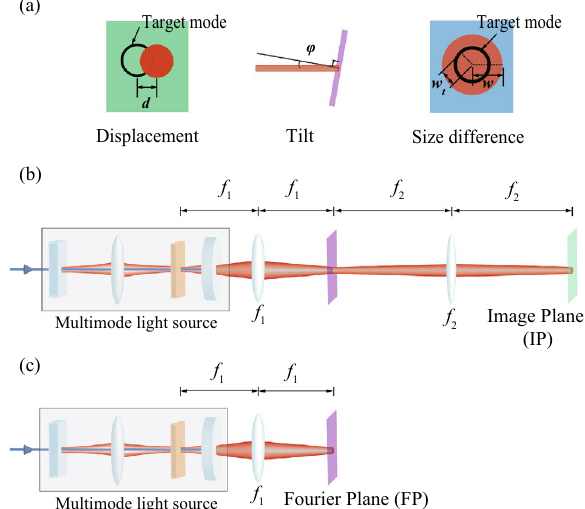
Figure 3. ( a ) Types of spatial mode mismatch. The displacement and the tilt are drawn in the x -direction for clarity, but they can be generalized to arbitrary directions. ( b ) 4f system for transformation into the image plane (IP). Two lenses of focal lengths f 1 and f 2 are used. ( c ) Transformation into the Fourier plane (FP) by employing a single lens (focal length: f 1